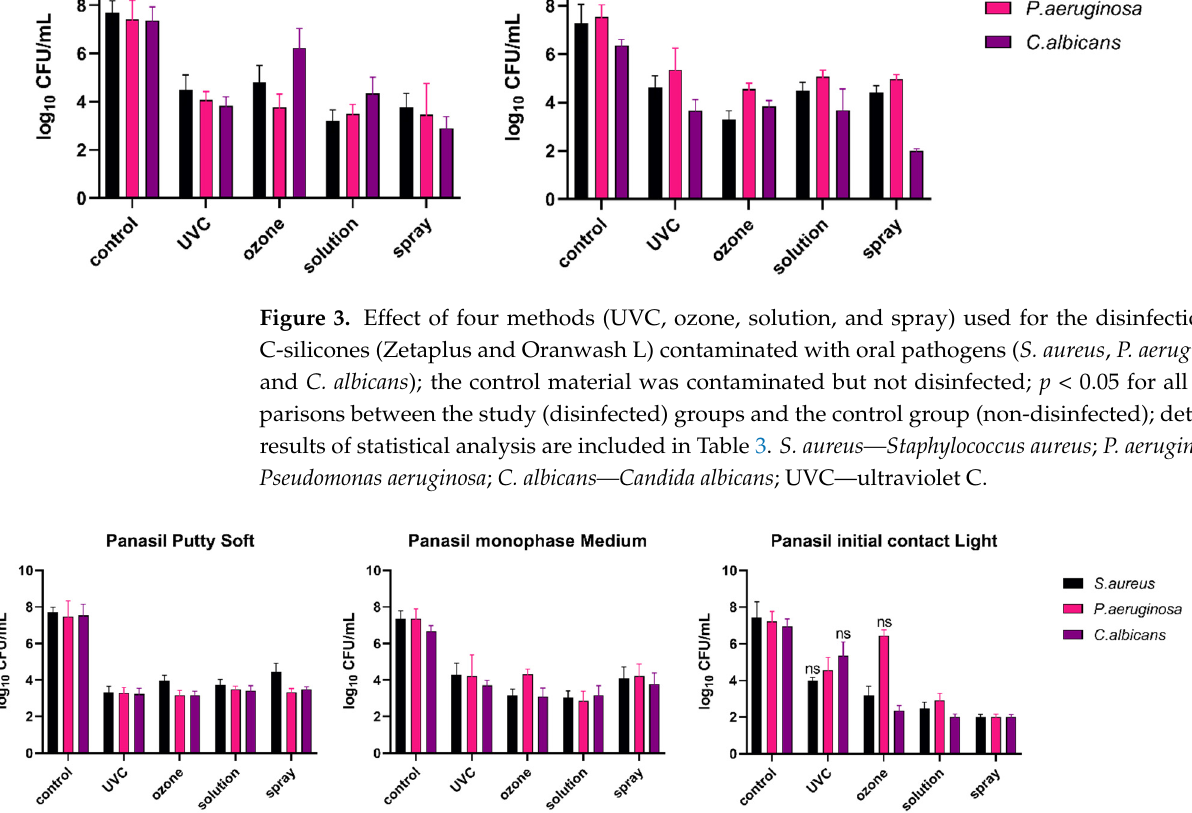
Figure 4. Effect of four methods (UVC, ozone, solution, and spray) used for disinfection of A-silicones (Panasil Putty Soft, Panasil monophase Medium, and Panasil initial contact Light) contaminated with oral pathogens ( S. aureus , P. aeruginosa , and C. albicans ); Control material was contaminated but not disinfected; ns —not significant ( p > 0.05); for all other comparisons between the study (dis- infected) groups and the control (non-disinfected) group, differences were significant ( p < 0.05); detailed results of statistical analysis are included in Table 3. S. aureus — Staphylococcus aureus